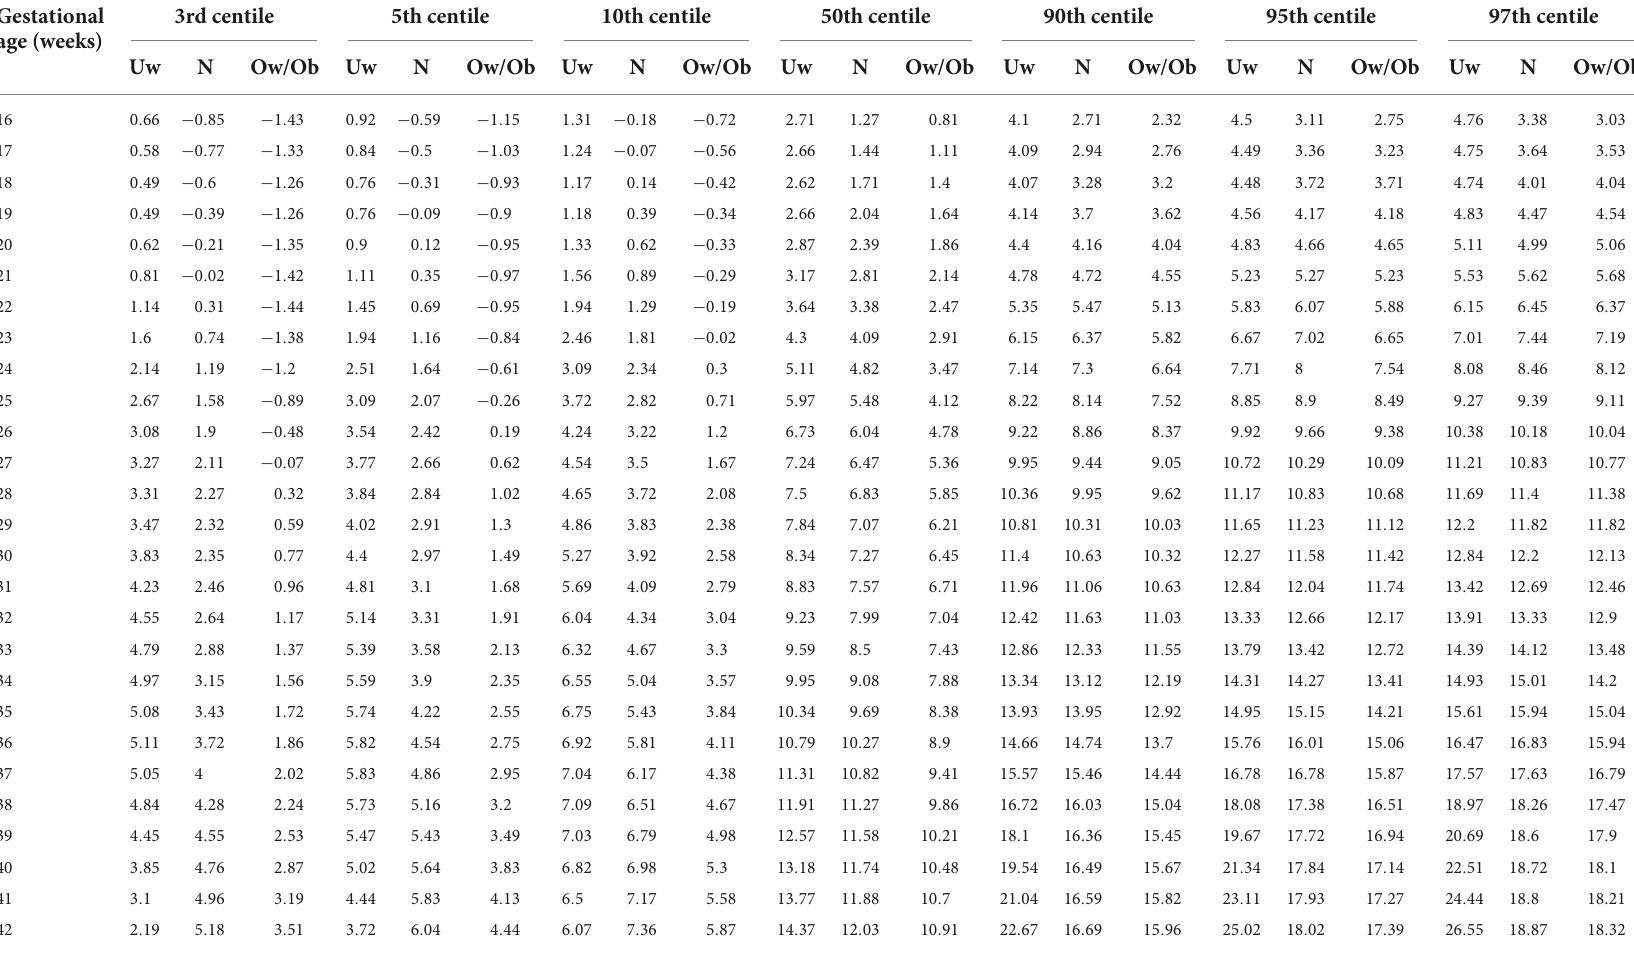
TABLE 3 Percentiles of cumulative GWG (in kg) at various gestational ages (in weeks) among different first trimester BMI